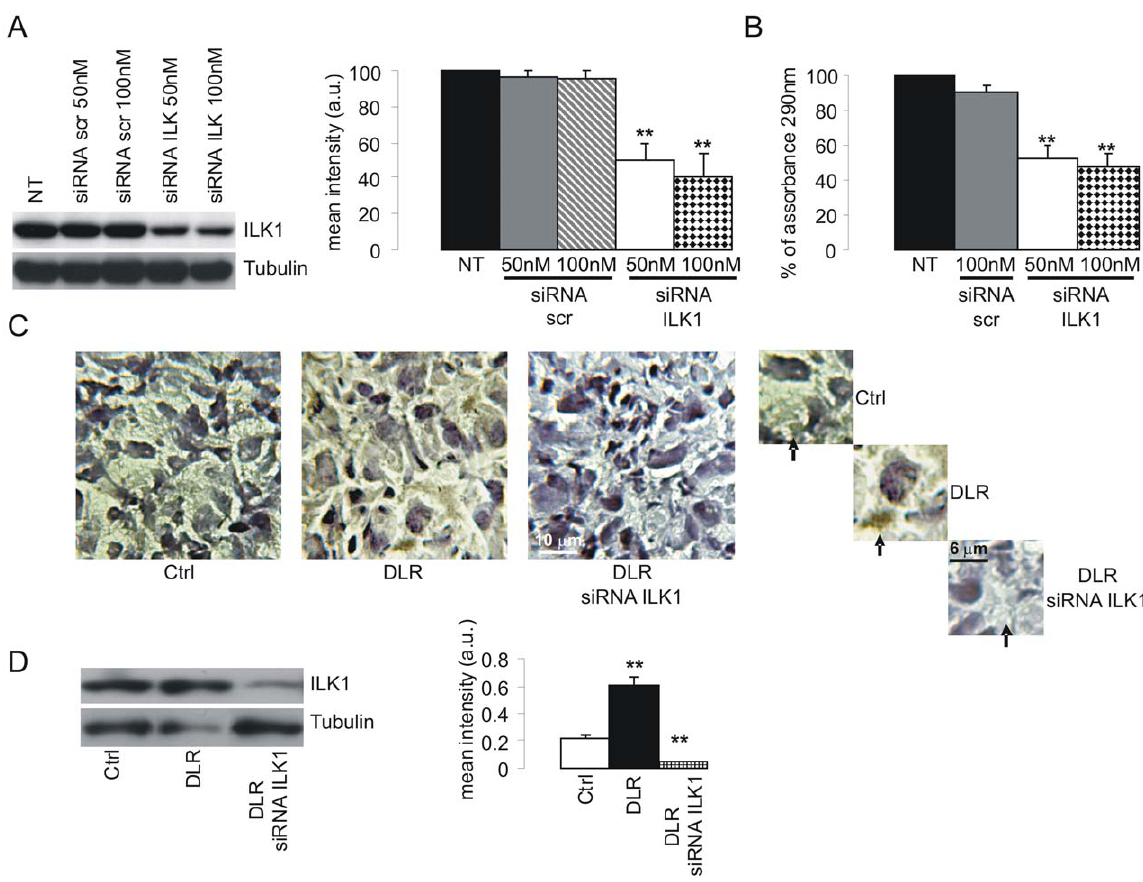
Figure 4. Characterization of specific siRNA for ILK1. A) U87 cells were transiently transfected with ILK1-specific siRNA using Lipofectamine 2000 or nontransfected (NT) as described in Materials and Methods, and harvested 48 h later; untreated cells or a non-silencing scrambled siRNA (Scr) were included as controls. ILK1 expression was specifically reduced in the cells transfected with ILK1 siRNA. Histogram shows of the mean band intensity ( 6 SEM) of each protein. **p , 0.01, one-way ANOVA with post hoc Tuckey test.B). Effect of the administration of ILK1 siRNA in vitro using the MTT test of cell proliferation. ILK1 siRNA 50 nM and 100 nM respectively led to the 48% and 53% inhibition of cell proliferation (columns 3 and 4); 100 nM of scrambled siRNA (Scr 100 nM) did not reduce cell proliferation (compare columns 1 and 2). NT: not transfected. Histogram shows mean % of assorbance at 290 nm. **p , 0.01, one-wayANOVA with post hoc Tuckey test. C and D) Effect of the administration of ILK1 siRNA in vivo ; representative immunohistochemistry (C) (Scale bar =10 m m) and Western Blot (D) analysis of ILK1 expression in tumors from untreated mice (ctrl), and mice treated with PF4-DLR alone (DLR) or PF4-DLR plus ILK1 siRNA (DLR siRNA ILK1). ILK1 levels were significantly reduced in the mice treated with ILK1 siRNA. Histogram in D shows of the mean band intensity ( 6 SEM) of each protein. **p , 0.01, one-way ANOVA with post hoc Tuckey